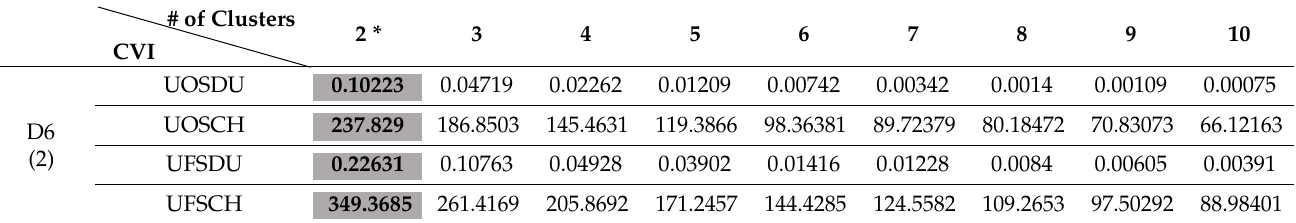
Table 7. Performance results for D6.